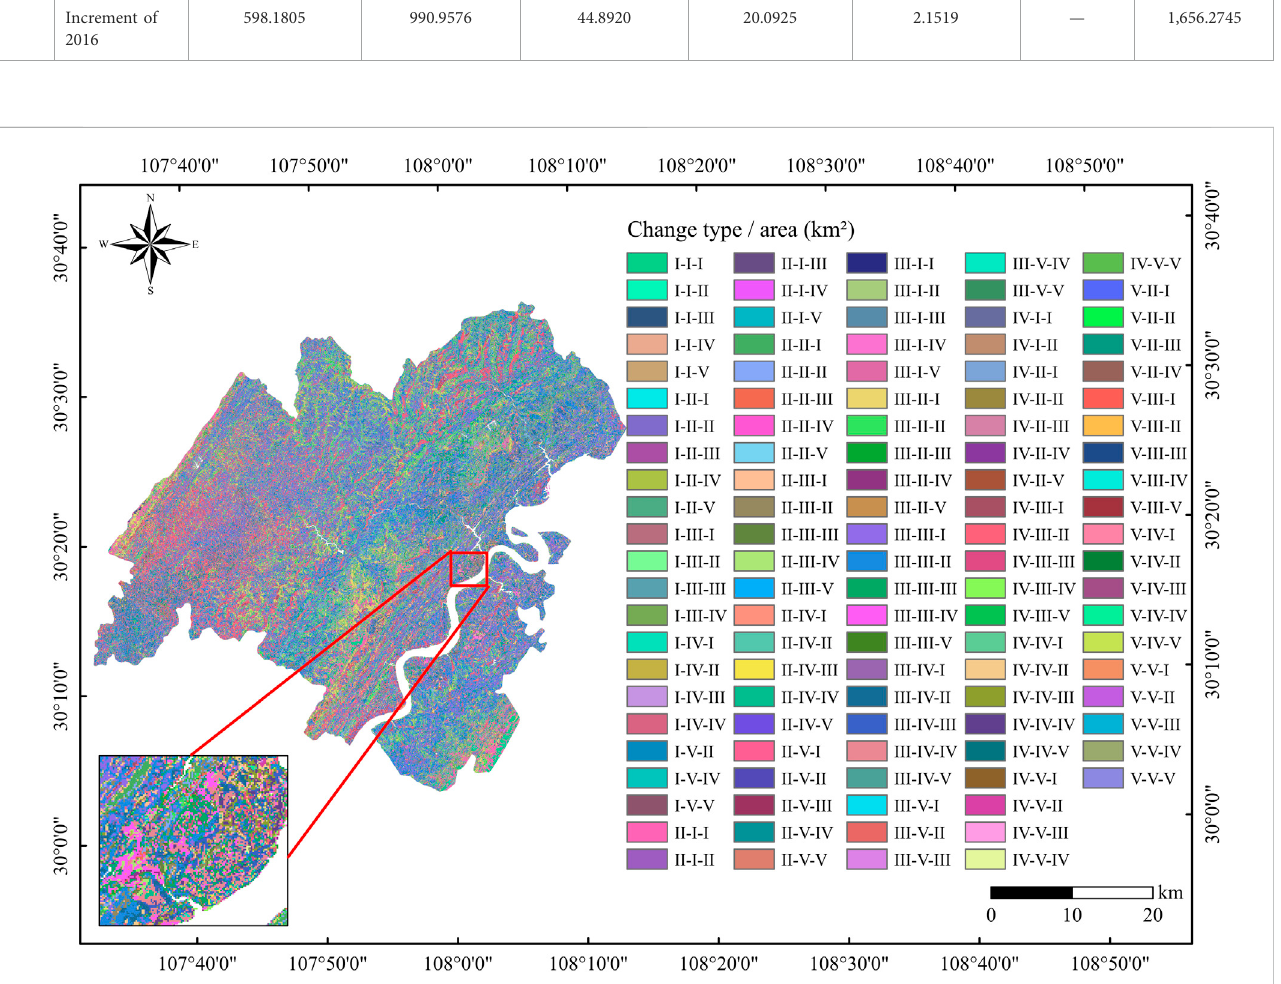
FIGURE 5 Temporal and spatial evolution pattern of ecological vulnerability in Zhongxian County from 2002 to 2016 (water mask treatment, the picture at the lower left corner shows the location of Zhongxian administrative center).